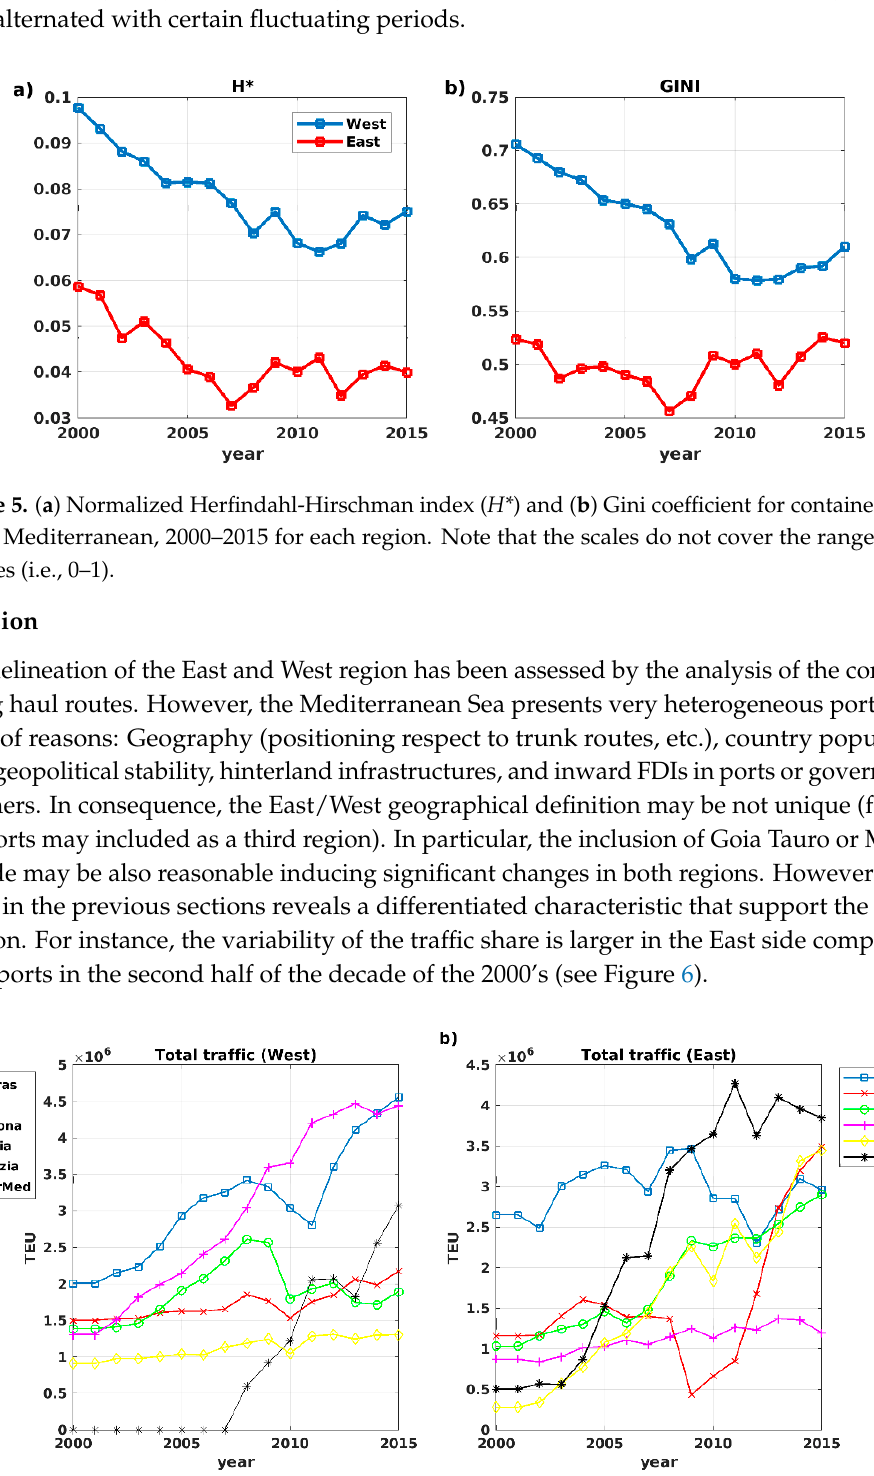
Figure 6. Traffic data for the 6 main ports in the West region ( a ) and the East region ( b ).